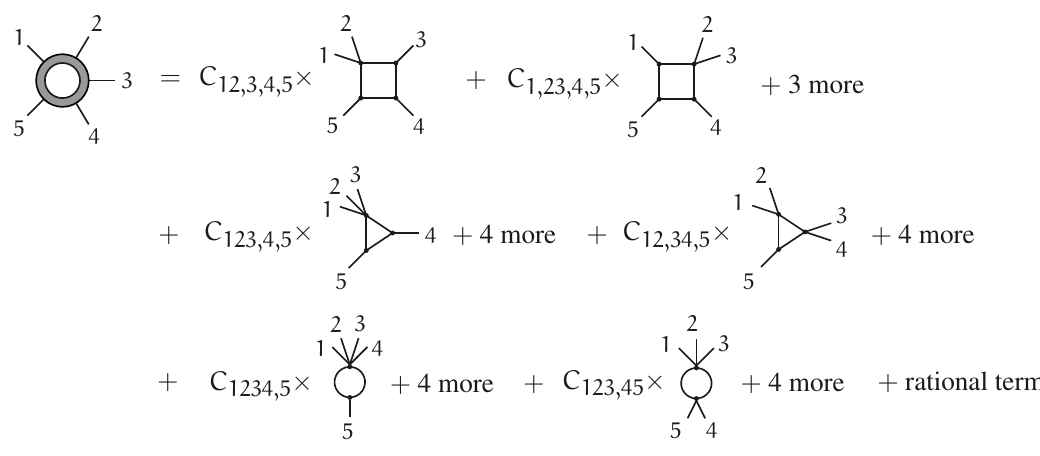
Figure 2 . Example of the decomposition of a planar one-loop amplitude with 5 external legs into scalar functions times their coefficients. One-point scalar functions are not included, and the decomposition only holds to and including O ( (cid:15) 0 ) . The rational terms are remainders that do not contain logarithms of the invariants of the external momenta, but cannot be captured within the scalar function decomposition. Essentially, to each possible cyclicly ordered partition of (1 , 2 , 3 , 4 , 5) into 4 , 3 or 2 groups belongs a